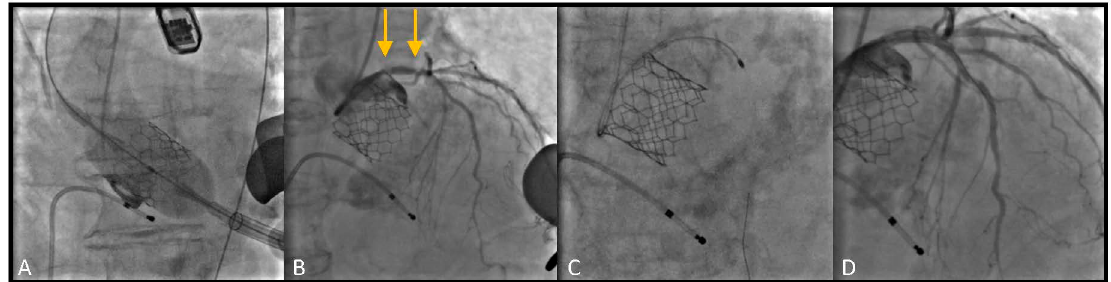
Figure 2. Rotational atherectomy (RA) following Edwards Sapien valve deployment by Trans-apical approach. ( A ) Balloon expandable valve (Edwards Sapien) deployment; ( B ) Pre RA angiographic evaluation of the lesion: severe calcified lesion of the ULM and ostial LAD (arrows); ( C ) Multiple Burr (RotaPro 1.5 mm) advancements; ( D ) Final result, after stent deployment and post dilation.